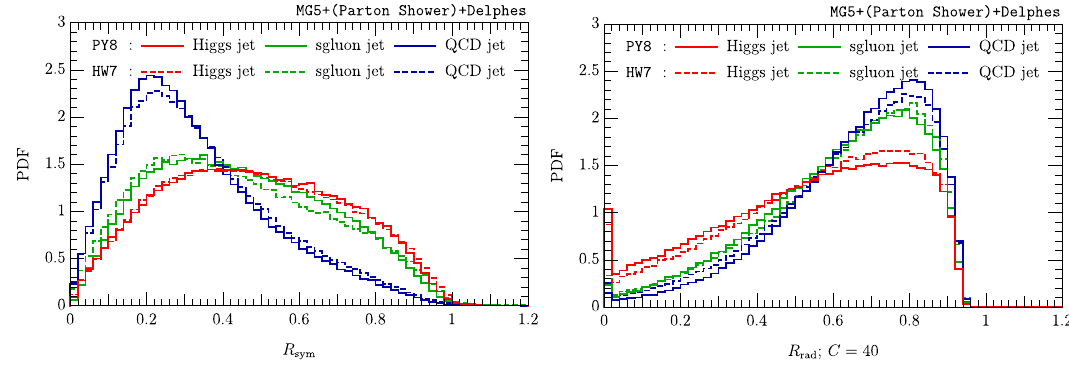
Figure 5 . The distribution of R prong ; sym (left) and R rad (right) for Higgs jet (red), sgluon jet (green), and QCD jet (blue). The solid (dashed) lines correspond to the jets of PY8 ( HW7 ) samples.